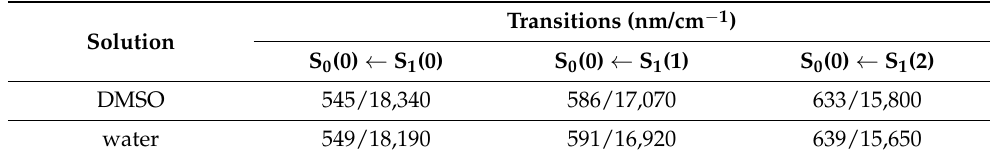
Table 2. Positions of PL band maxima of 2416SL solutions.